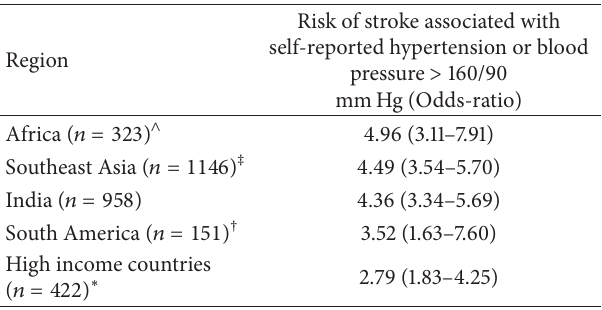
Table 1: Regional differences in the risk of stroke associated with hypertension (Adapted from: “O’Donnell, et al.